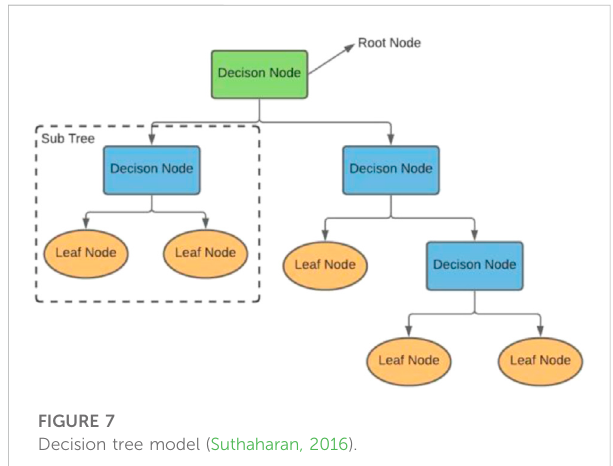
FIGURE 7 Decision tree model (Suthaharan,